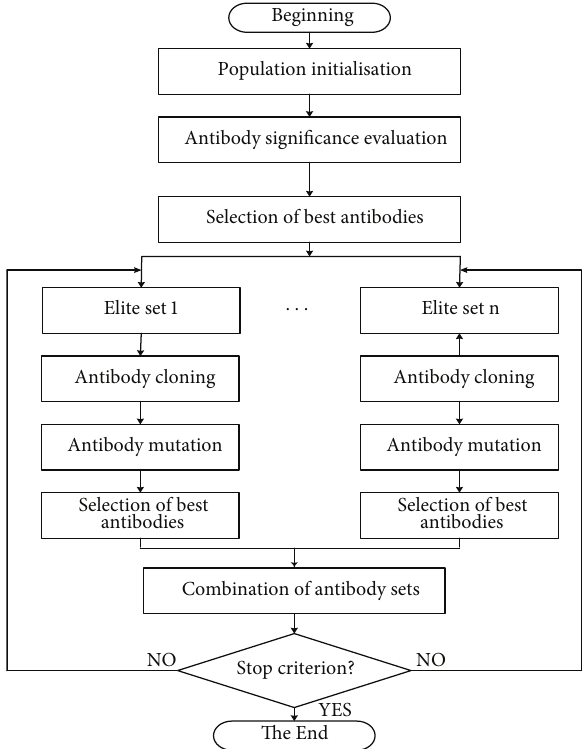
Fig. 3. General view of the clonal immune algorithm for the task fulfilment calendar of aeronautical system